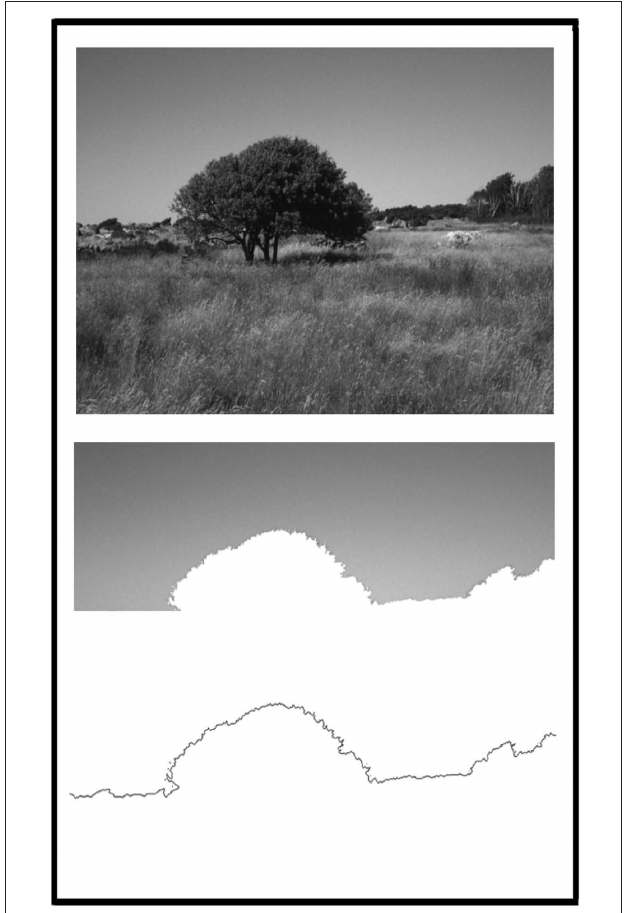
FiGurE 9 | The processing steps used in the extraction of the fractal skyline contour of a natural scene. Top: one of the natural scenes shown to subjects. Middle: an intermediate processing step used to extract the skyline contour. Bottom: the extracted skyline contour subjected to the box-counting